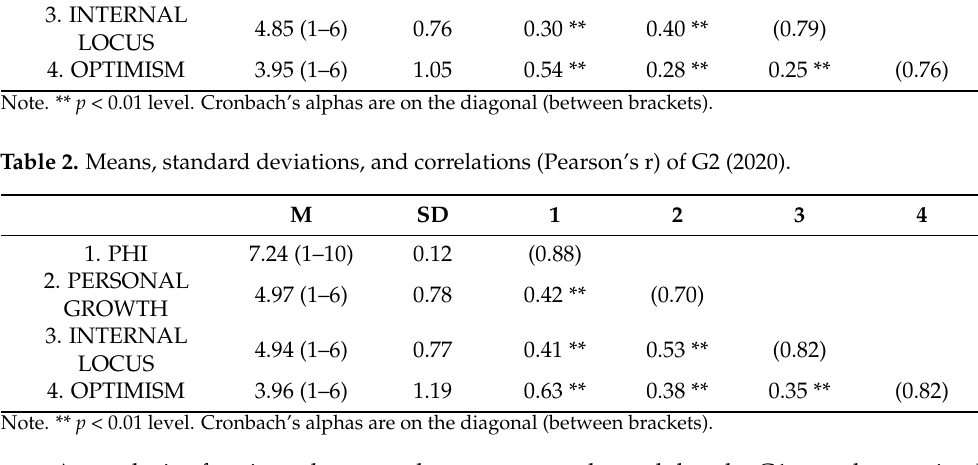
Table 1. Means, standard deviations, and correlations (Pearson’s r) of G1 (2019). M SD 1 2 3 4 1. PHI